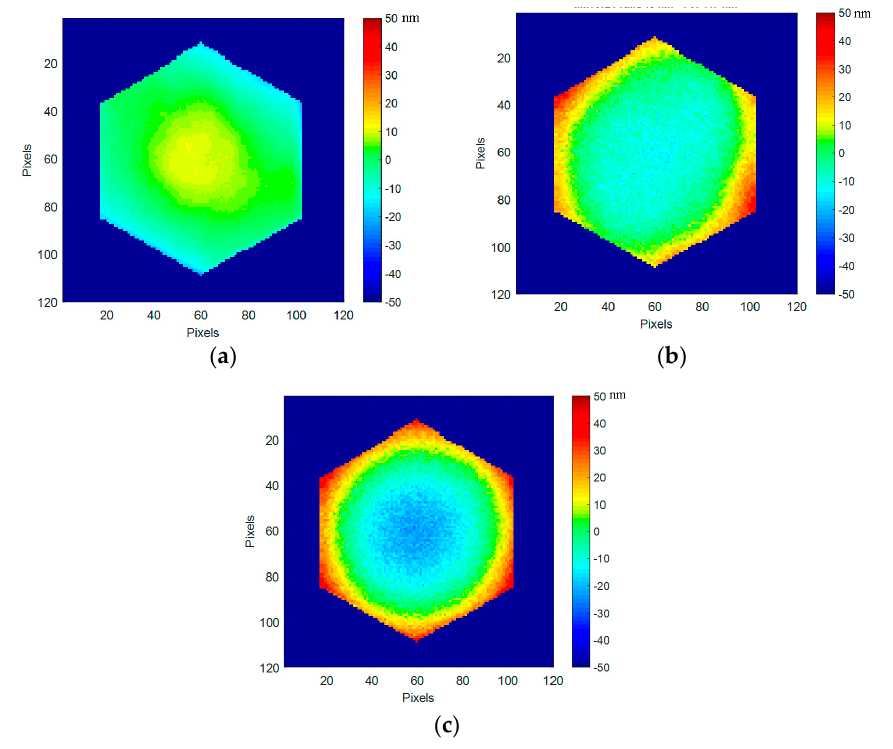
Figure 17. DM segment #21 surface deformation: ( a ) At ambient (293 K), 5 nm RMS, 24 nm PtV; ( b ) At 160 K 8 nm RMS, 47 nm PtV; ( c ) Deformation difference between ambient and 160 K, 4.9 nm RMS, 71 nm PtV.